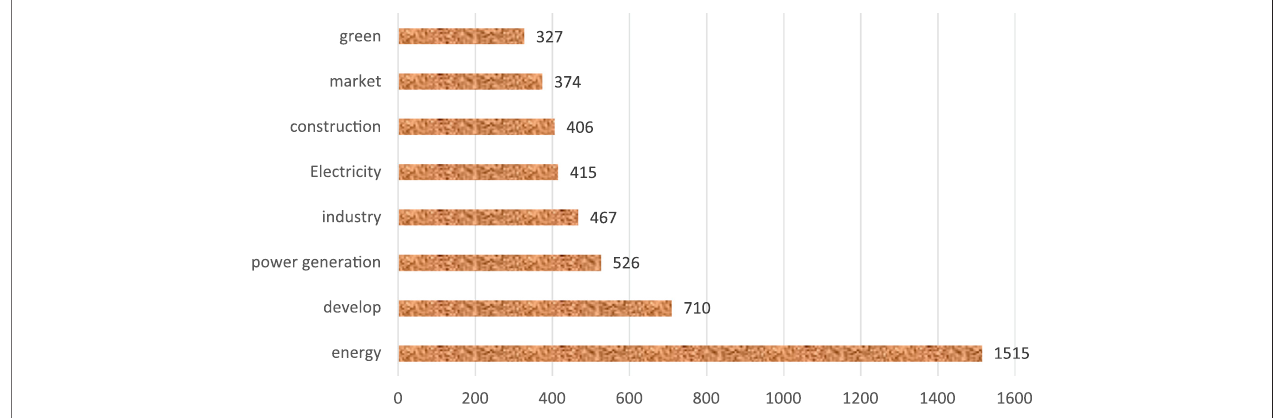
FIGURE 6 | Most mentioned keywords for “ photovoltaic and carbon-neutral “ in Weibo microposts.